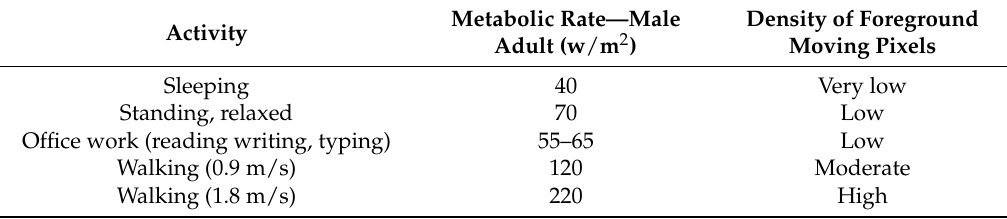
Table 2. General relationship between metabolic rate and density of foreground moving